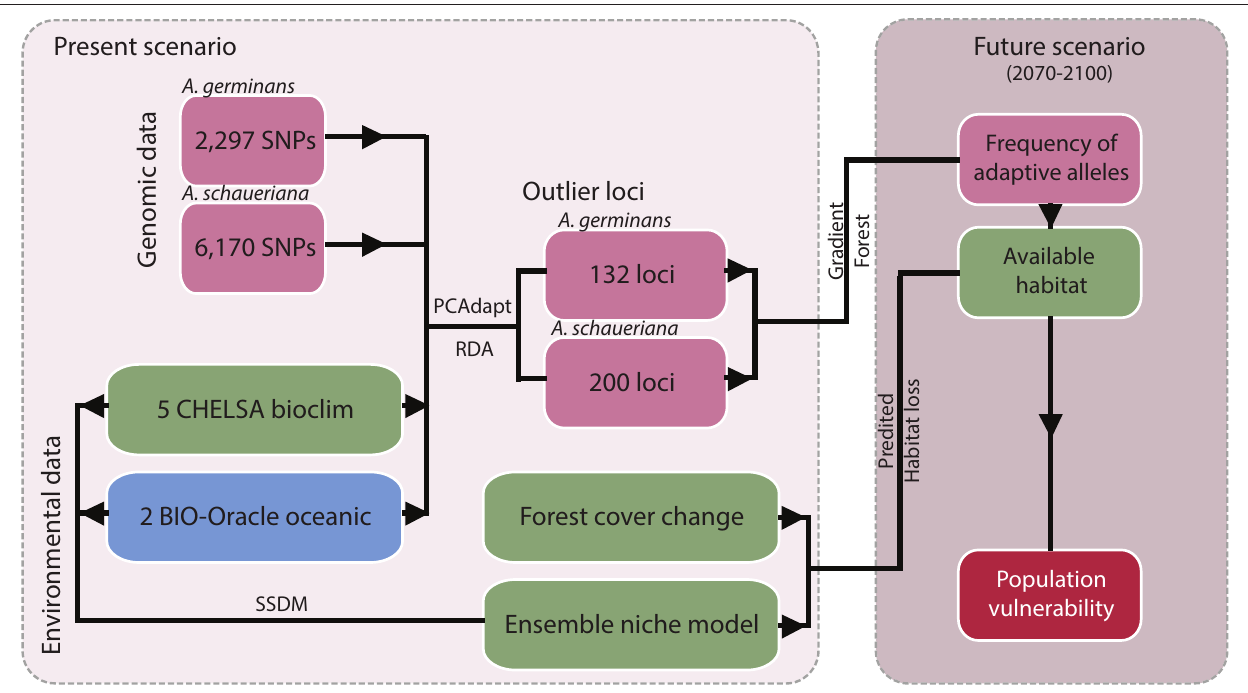
FIGURE 1 | Diagram of the analyses and datasets applied to estimate the vulnerability of individual populations to climate change based on the projected adaptive allelic frequencies and habitat